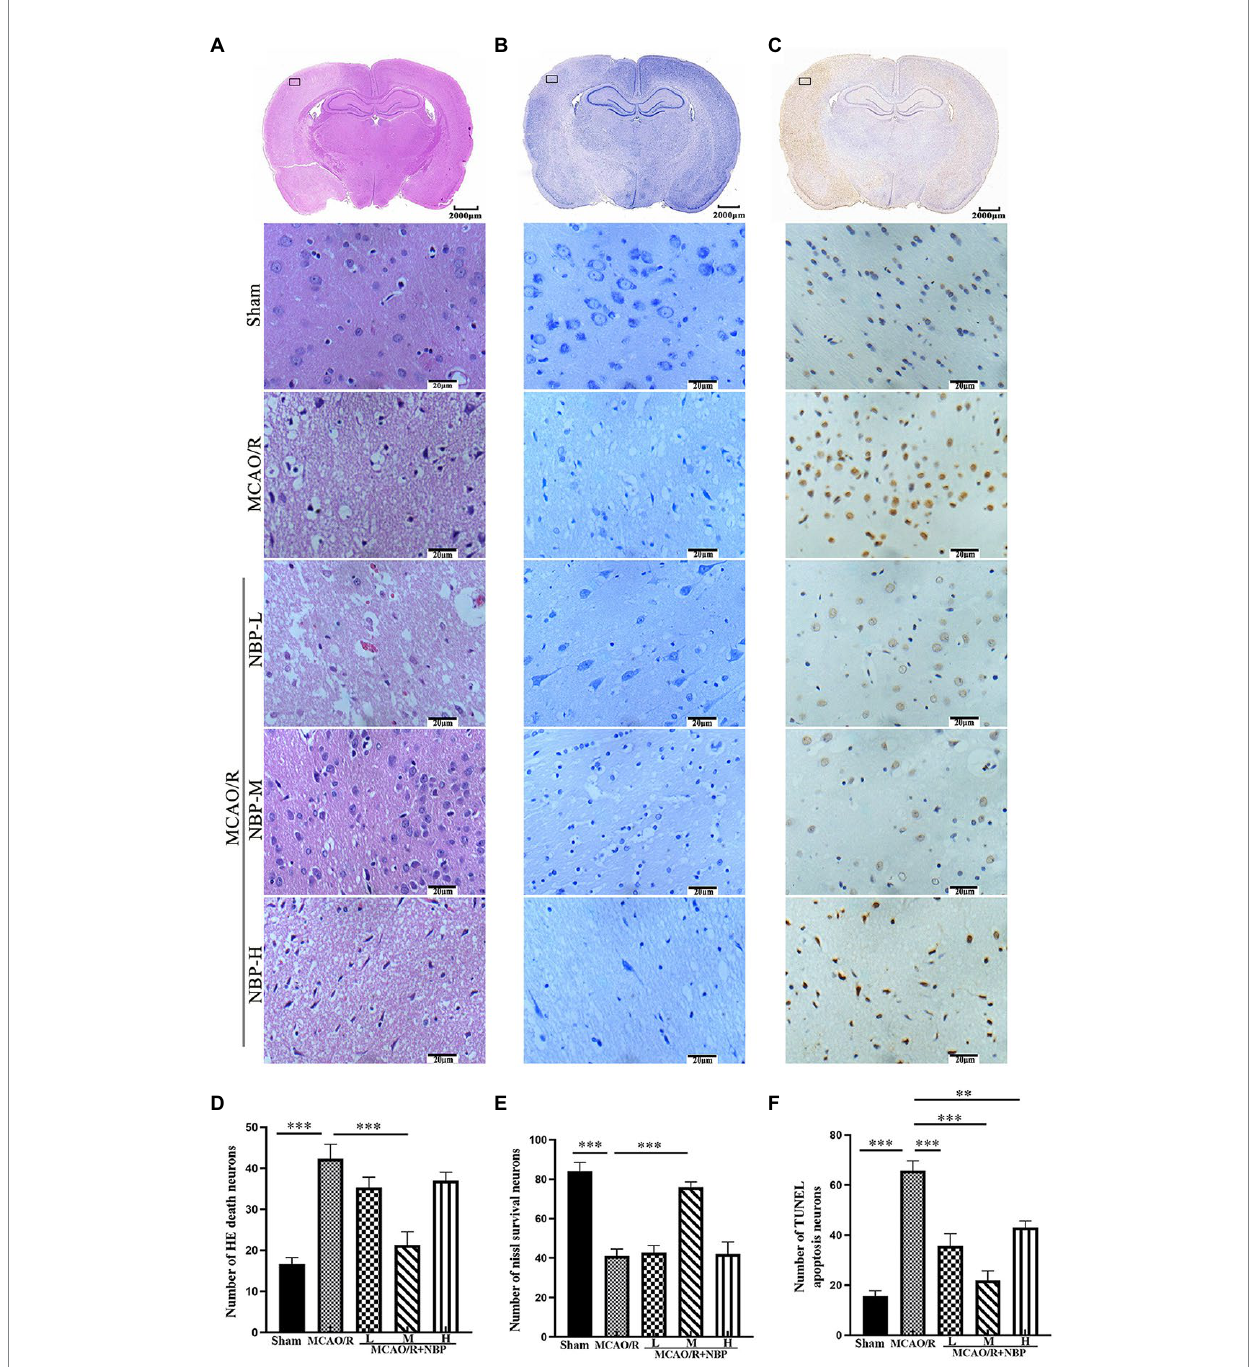
FIGURE 2 The histopathological and structural changes by HE, Nissl, and TUNEL staining. (A) HE staining. (B) Nissl staining. (C) TUNEL staining. (D–F) Quantitative analysis of the staining above (×400). HE, hematoxylin and Eosin; TUNEL, terminal deoxynucleotidyl transferase dUTP nick-end labeling. * p < 0.05; ** p < 0.01; *** p < 0.001. Data are presented as the mean ± SD, n =